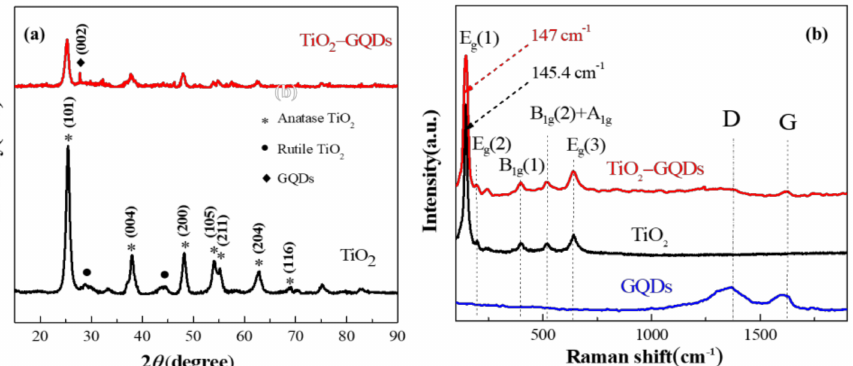
Figure 4. ( a ) XRD results of pristine TiO 2 and TiO 2 -GQDs caterpillar hybrid. The symbols of “*”, “ • ”, and “ (cid:7) ” correspond to the anatase TiO 2 , rutile TiO 2 , and GQDs, respectively. ( b ) Characteristic Raman spectra of pristine TiO 2 caterpillar, GQDs and TiO 2 -GQDs caterpillar hybrid. The Raman of TiO 2 and GQDs are marked with standard symbols. To ensure clarity, the curve moves